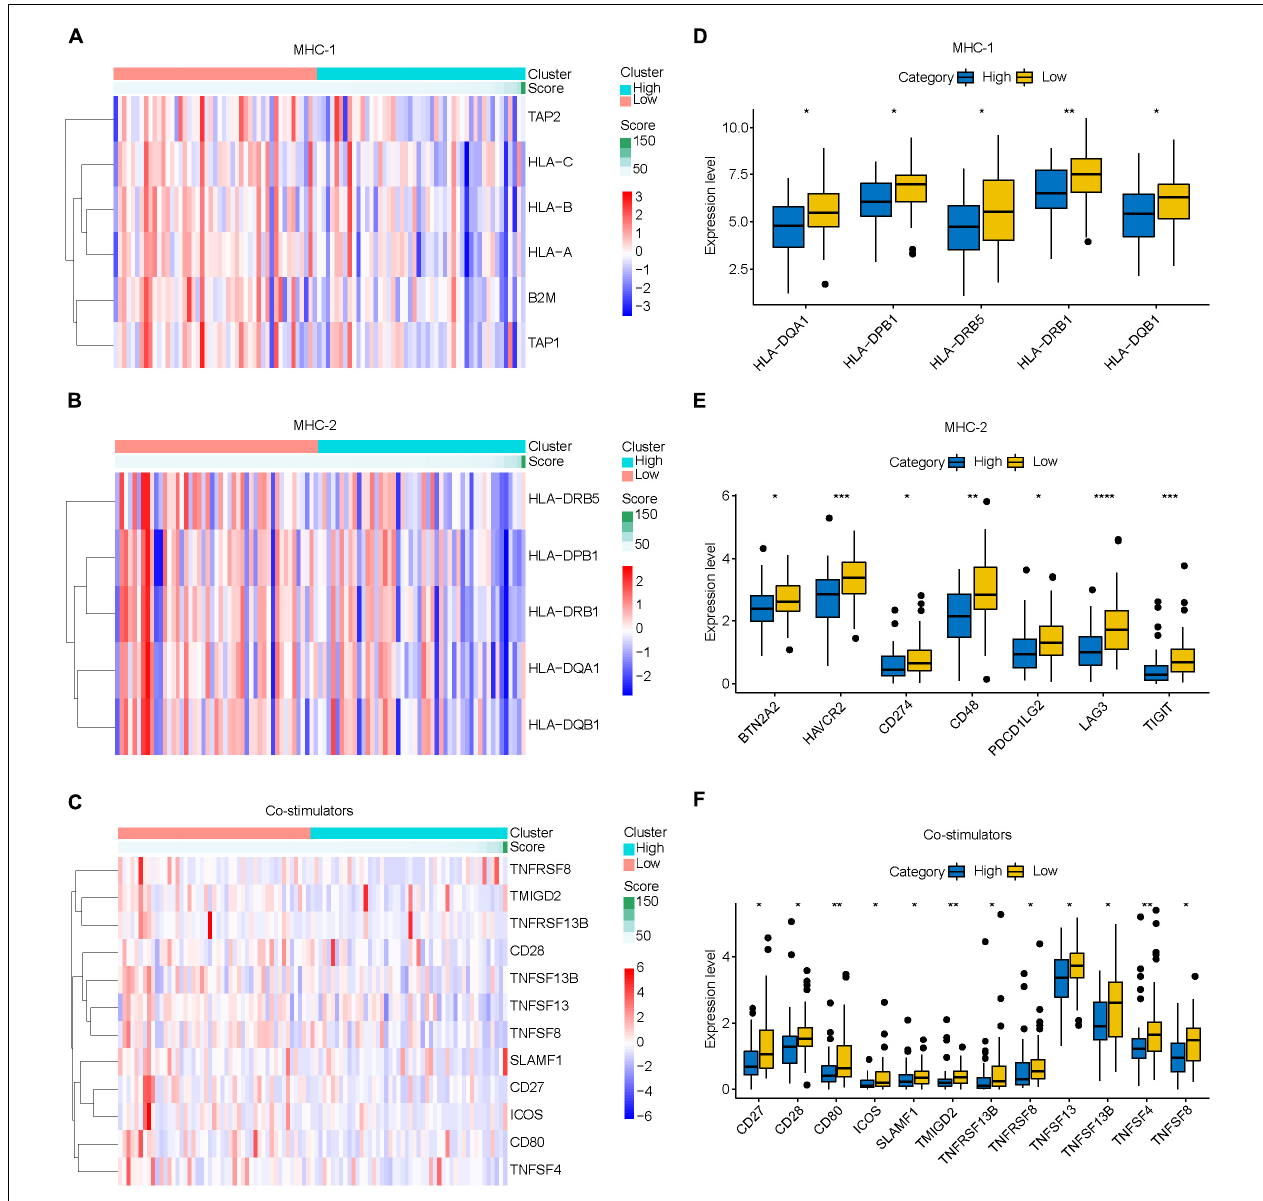
FIGURE 10 | Relationship between IRLs signature and endogenous immune escape in osteosarcoma. (A–C) The expression of MHC-I molecule, MHC-II molecule, and costimulatory molecule changed with the increase of risk score. (D–F) Differential analysis of the expression of MHC-I, MHC-II, and costimulatory molecules in high-risk and low-risk osteosarcoma. * P < 0.05; ** P < 0.01; *** P < 0.001; **** P <